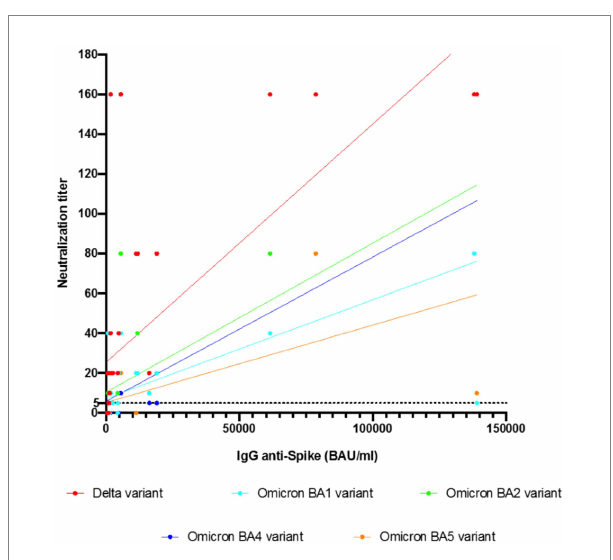
FIGURE 4 Correlation analyses of anti-spike Ab with neutralization titers of the sera from 39 kidney transplant recipients against the different SARS- CoV-2 variants by simple linear regression. The correlation was performed by Pearson’s analysis. The concentrations of anti-spike Ab showed a strong correlation with the neutralization titer for each variant. The Pearson r was 0.72, 0.57, 0.67, 0.68, and 0.71 for the Delta, Omicron BA.1, Omicron BA.2, Omicron BA.4, and Omicron BA.5 variants, respectively; p <